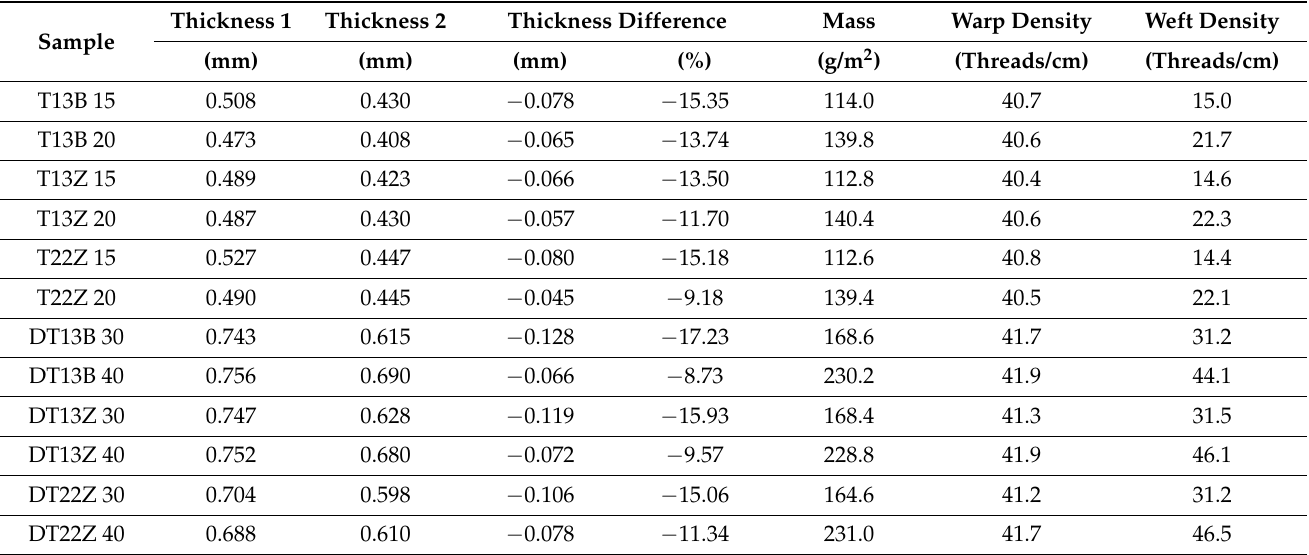
Table 2. Measured values of physical properties of woven fabrics used as substrates for 3D printing (Thickness 1 and Thickness 2 (mm), thickness difference (mm, %), warp (threads/cm) and weft density (threads/cm), and mass per unit area (g/m 2